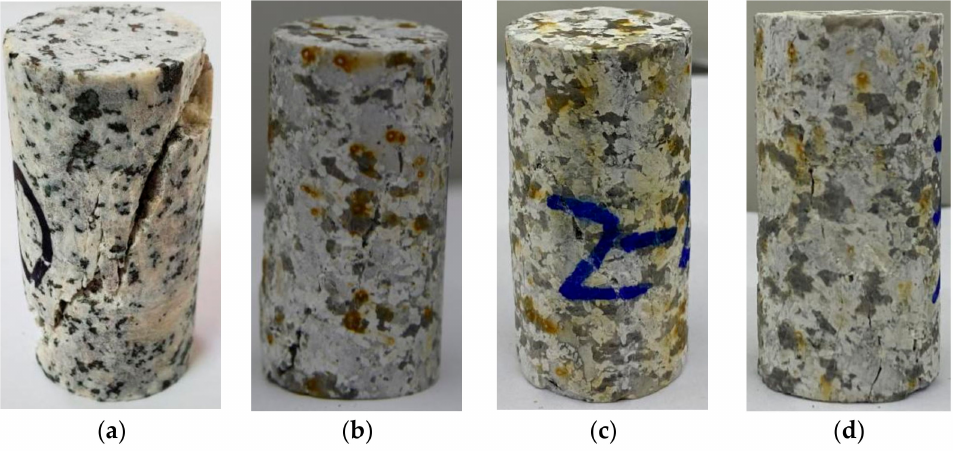
Figure 5. The granite samples after triaxial compression tests: ( a ) S0; ( b ) S1; ( c ) S2; ( d ) S3.